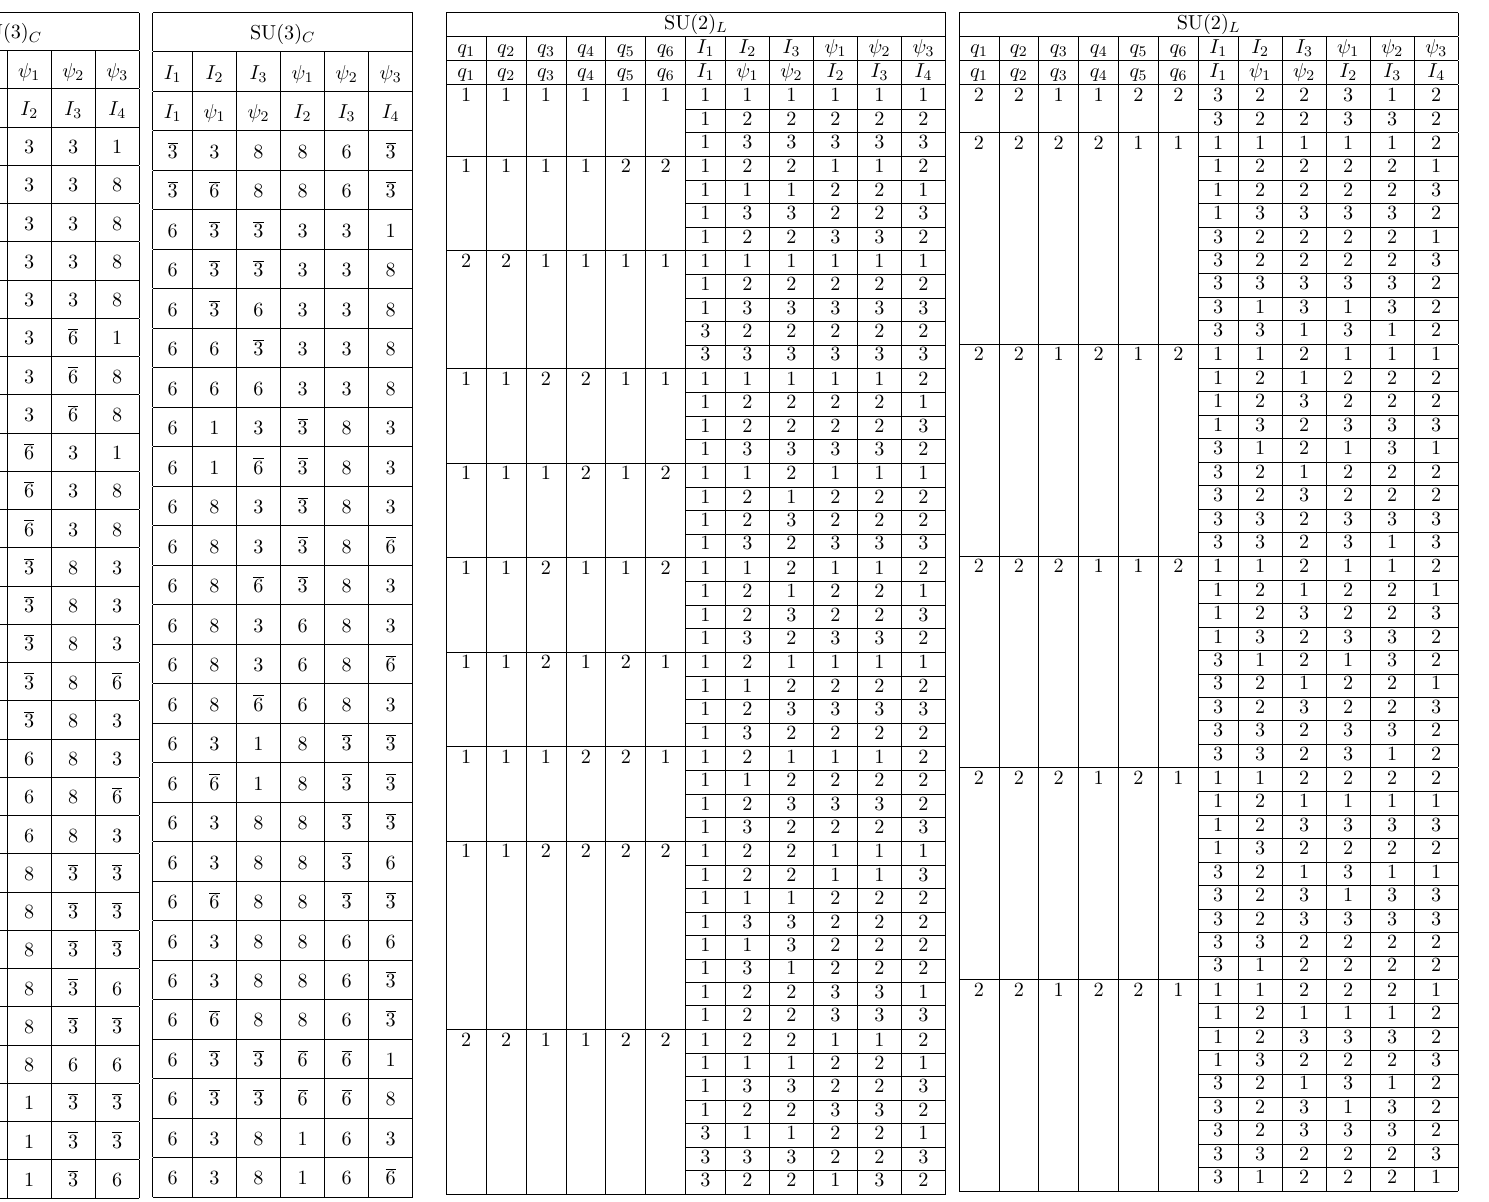
Table 9 . The possible SU(3) C and SU(2) L numbers of the fields in